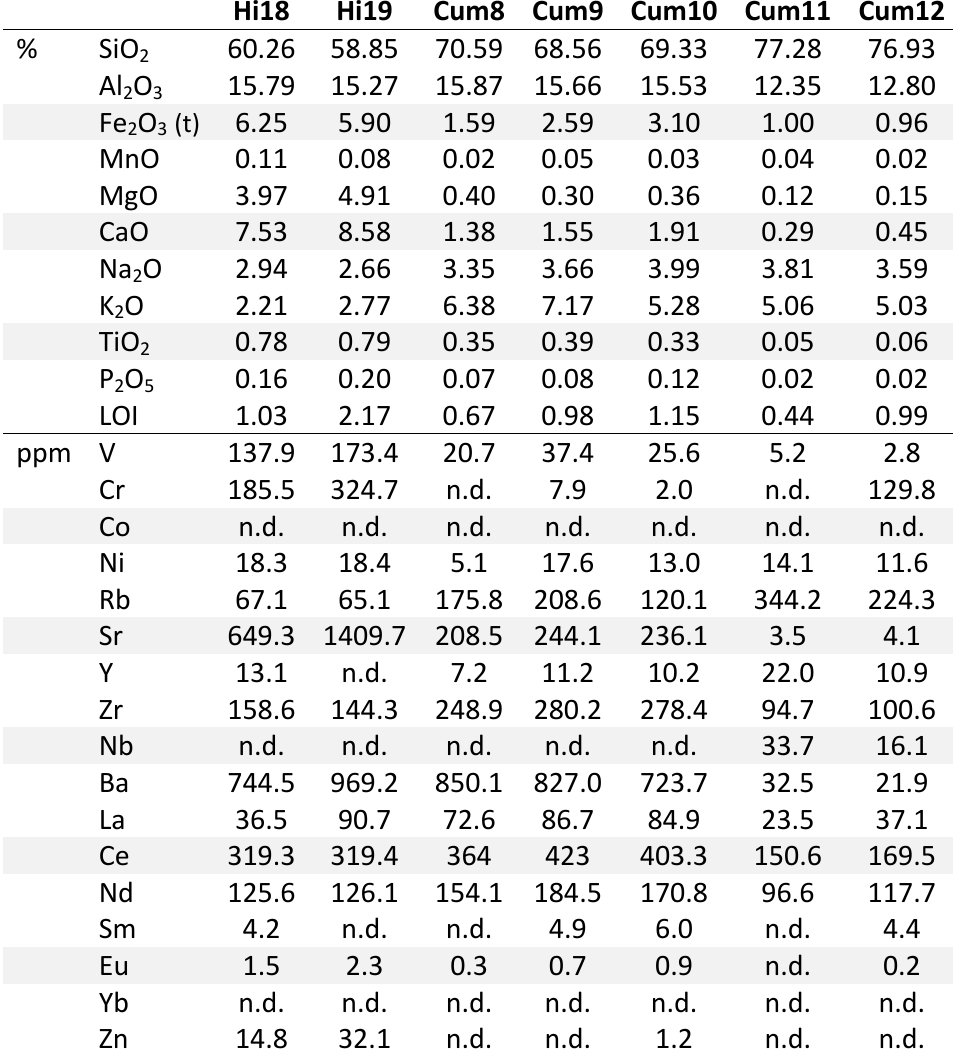
Table 3. Major and trace element composition of the geological Hisartepe (Hi) and Cumaovası (Cum) samples (normalized; ‘n.d.’ not determined, below detection limit of